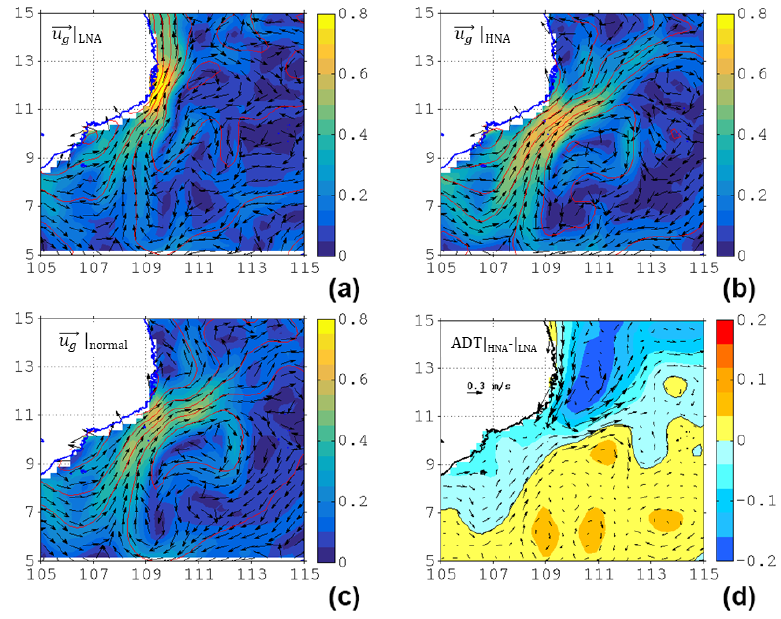
Figure 4. The surface current velocity (color shading, unit: ms − 1 ), direction (vectors), and respective ADT (red contours, unit: m) in (a) LNA, (b) HNA, and (c) normal months (i.e., neither LNA nor HNA) scenarios (see text for criteria). (d) The differences of ADT and current between HNA and